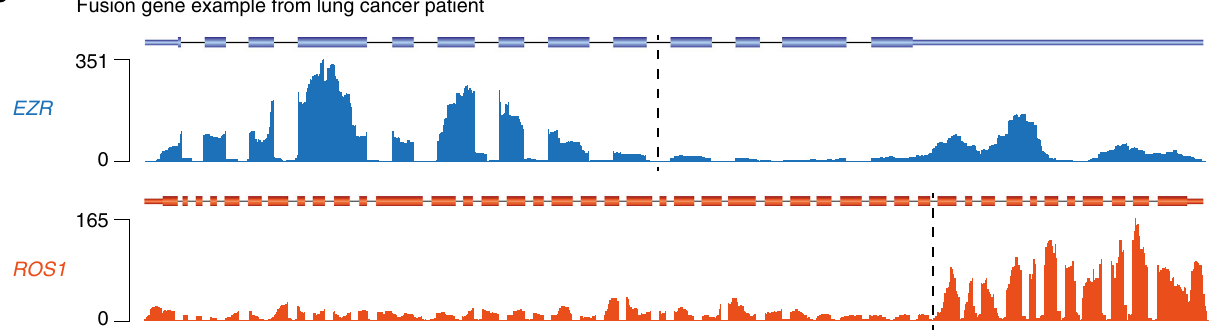
(38%) samples with fusion genes identi fi ed by a single fusion- fi the inverse of the fusion gene previously identi fi ed and one